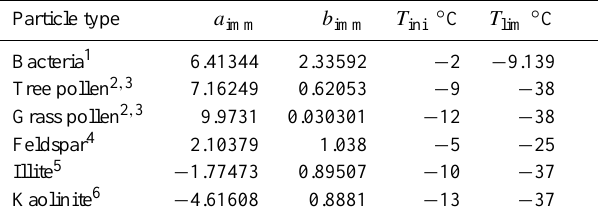
Table 1. Values of immersion freezing constants in Eq. (2). Based on data from 1 Wex et al. (2015), 2 Diehl et al. (2002), 3 v. Blohn et al. (2005), 4 Atkinson et al. (2013), 5 Hiranuma et al. (2015), and 6 Murray et al.